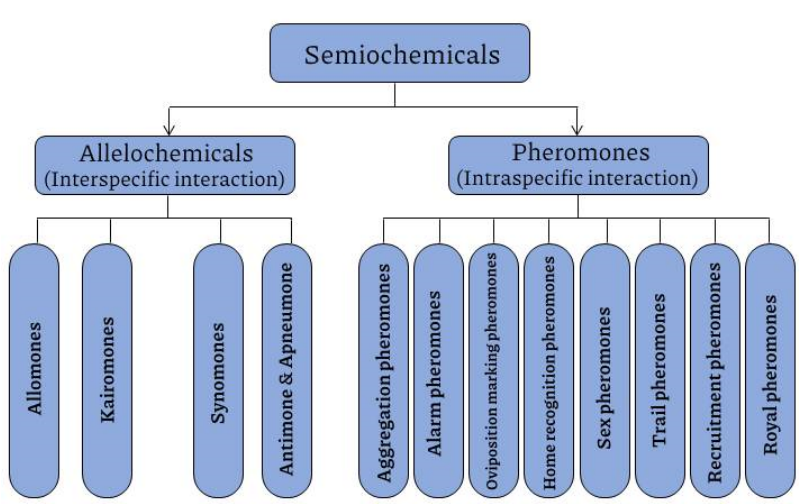
Figure 2. Diverse compounds of semiochemicals in hematophagous insects including bed bugs.